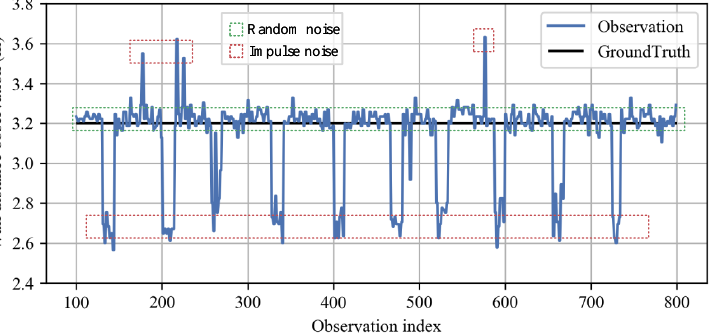
Figure 5. Classification of wall distance observation noise. The plot shows wall distance observations in a straight walking test along a parallel wall. The random noise with small amplitude comes from inherent radar ranging error, while the impulse noise with larger amplitude comes from signal fluctuation or wall barrier structures.